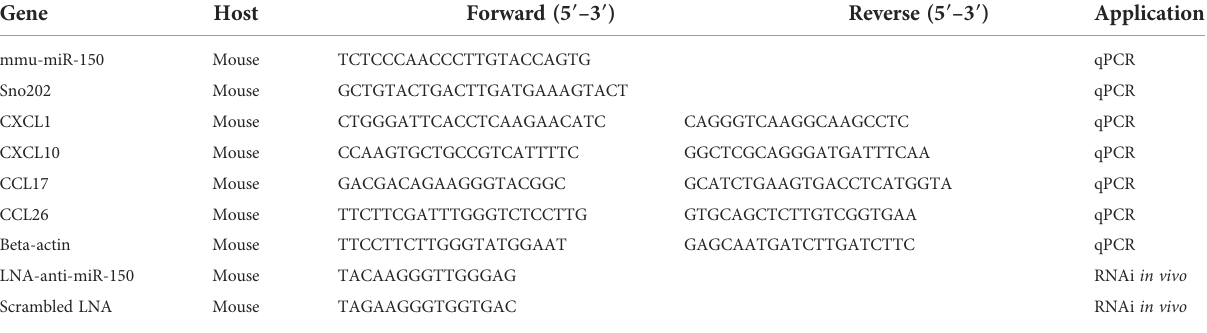
TABLE 2 Sequence of RNA and RNAi used in the present study.